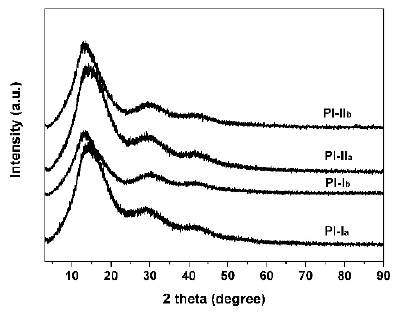
Figure 5. XRD spectra of PI films.